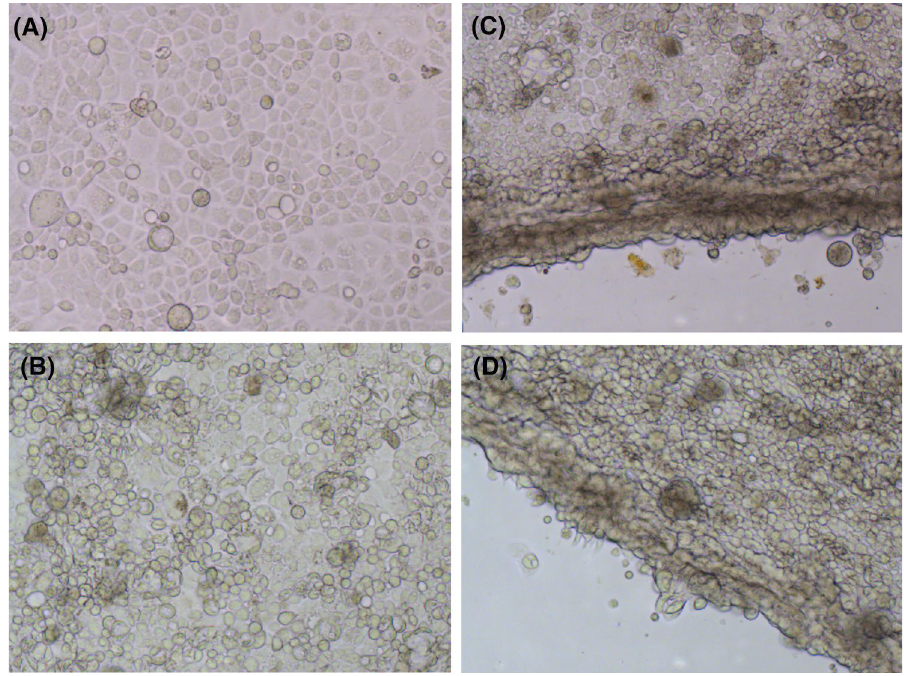
Figure 1. Caco-2 epithelial cell organisation. Cells were cultured on permeable membrane filter support for 20 days. Healthy cells ( A ) and their attachment to the membrane plate ( B ) in the presence of reference metal(loid) samples. Damaged cells ( C ) and their attachment to the membrane plate ( D ) in the presence of metal(loid) source samples used in bioaccessibility tests. Hence only reference metal(loid) samples were used for the bioavailability tests as measured by intestinal permeability using Caco-2 cell